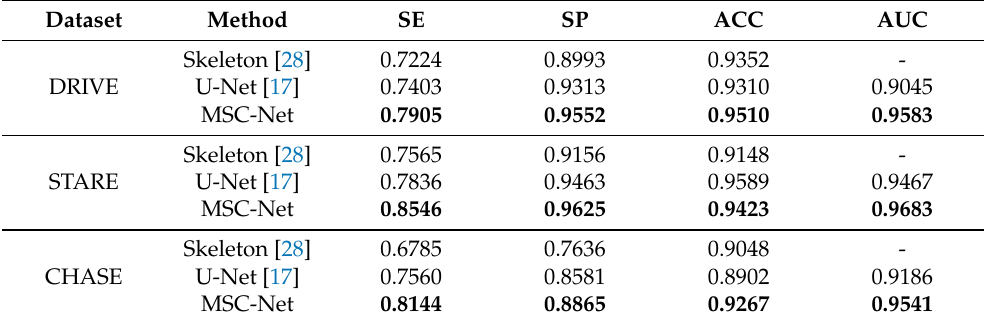
Table 4. SE, SP, ACC, and AUC scores of MSC-Net and other methods for centerline extraction on the test